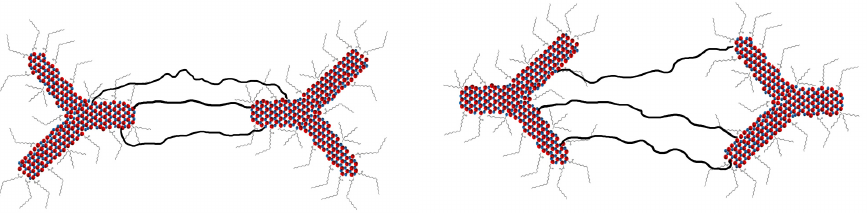
Figure 5. Possible schematic presentations of non-spherical CdSe QD bound with telechelic PMMA T2